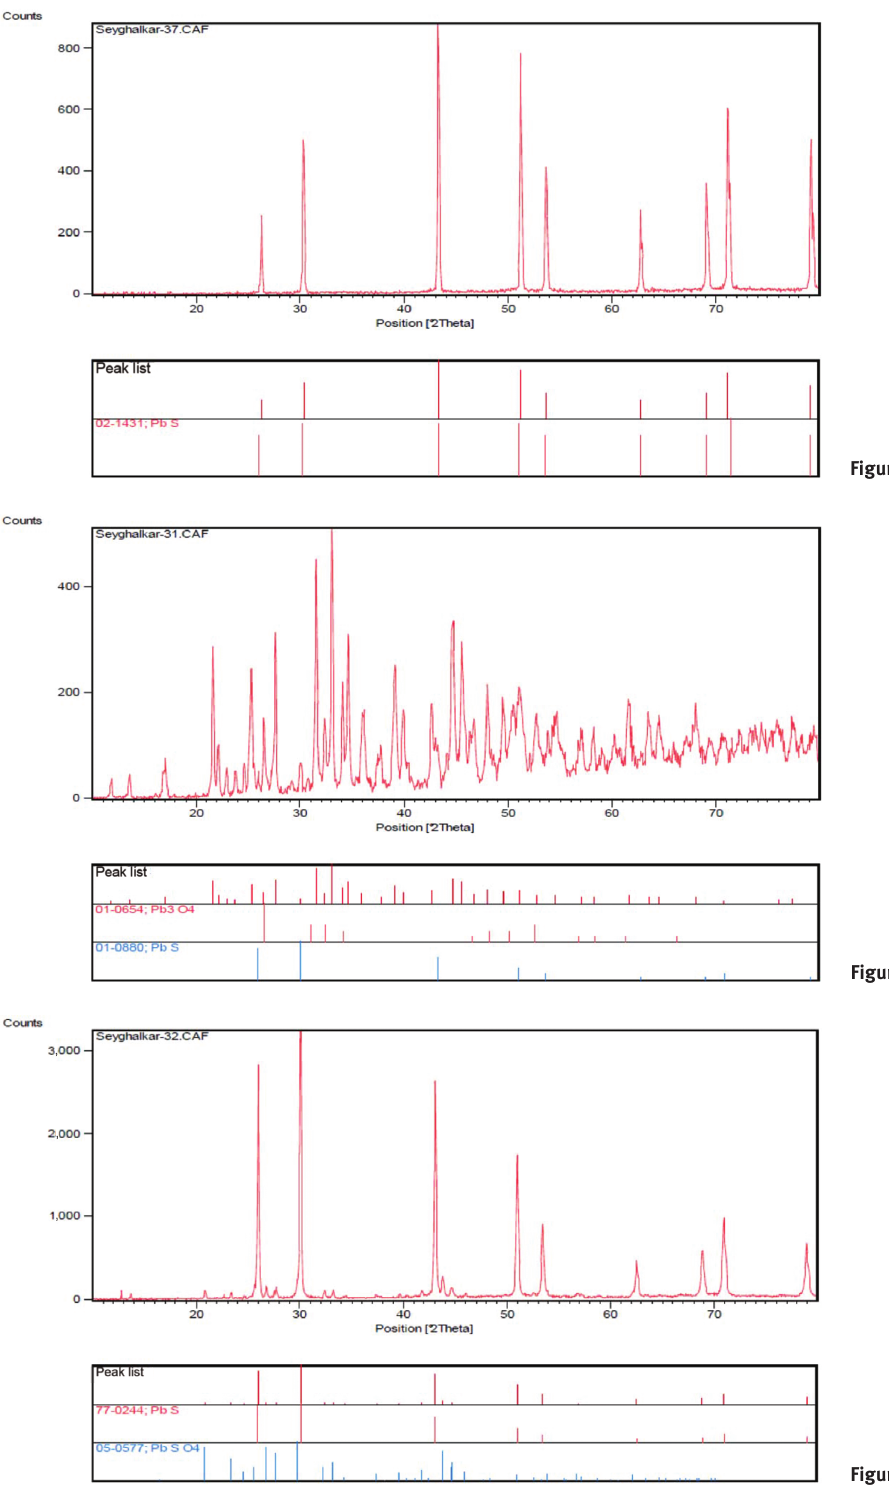
Figure 7: XRD pattern of sample no.